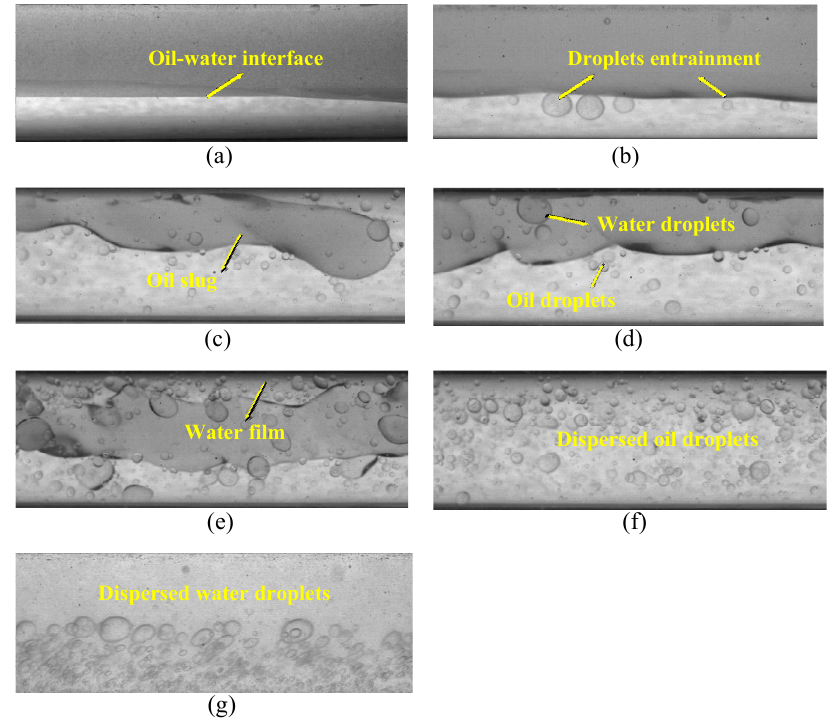
Figure 6. Typical oil–water flow images captured by the high-speed camera (0 ◦ ): ( a ) U sw = 0.184 m/s, U so = 0.162 m/s, ST; ( b ) U sw = 0.368 m/s, U so = 0.236 m/s, ST&MI; ( c ) U sw = 1.105 m/s, U so = 0.106 m/s, D OS &W; ( d ) U sw = 0.737 m/s, Uso = 0.552 m/s, D W/O&D O/W; ( e ) U sw = 1.105 m/s, U so = 0.552 m/s, D W/O&D O/W WF; ( f ) U sw = 1.67 m/s, U so = 0.236 m/s,